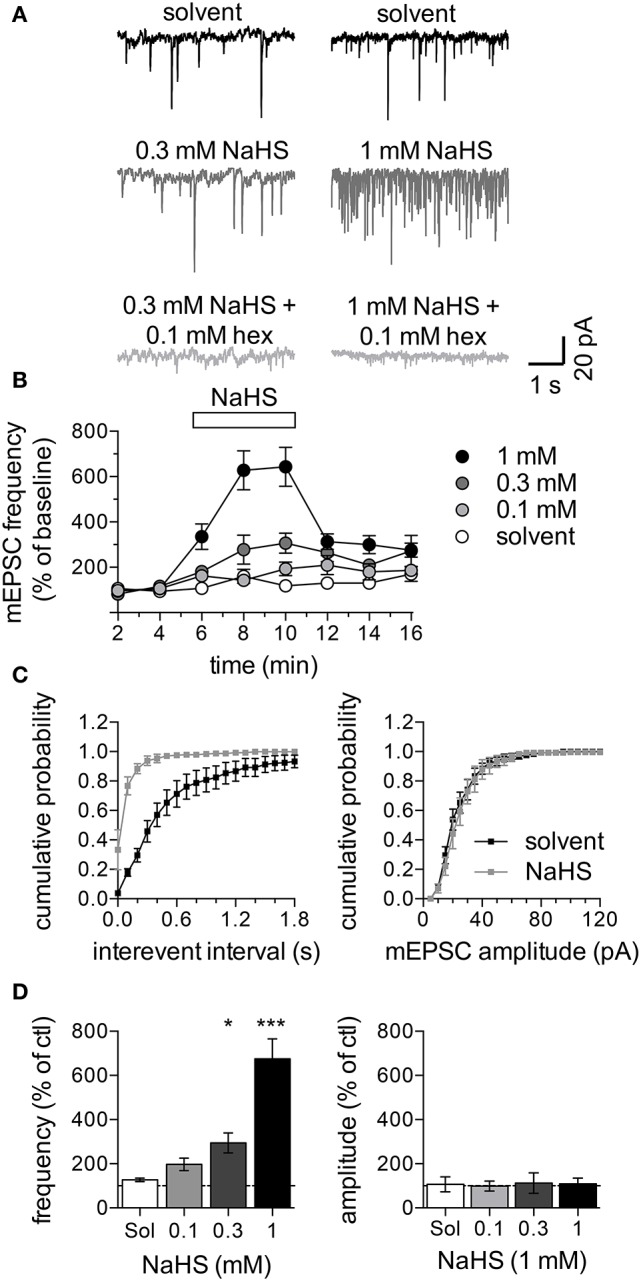
Effect of NaHS on mEPSCs in SCG neurons. mEPSCs were recorded in the perforated voltage-clamp mode in presence of 20 mM K+. (A) Representative current traces were recorded in the presence of solvent (black traces, top), 0.3 mM NaHS (dark gray, left) or 1 mM NaHS (dark gray, right) or either concentration of NaHS together with 0.1 mM hexamethonium (light gray, bottom). Panel (B) shows the time course of changes in mEPSC frequency in response to solvent (empty circles) or different concentrations of NaHS (0.1 to 1 mM, as indicated) which were present for 300 s as indicated by the rectangle. mEPSC frequencies are shown as percentage of the average control mEPSC frequencies recorded before the application of NaHS (n = 8). Panel (C) shows cumulative frequency distributions of mEPSC interevent intervals (left panel) and amplitudes (right panel) in presence of solvent (black squares) or NaHS (1 mM, gray squares) (n = 8). Panel (D) shows changes of mEPSC frequencies (left panel) and amplitudes (right panel) in response to solvent or different concentrations of NaHS (n = 8) determined at the end of the 300 s application period. * and *** Indicate significance differences vs. solvent at p < 0.05 and p > 0.001, respectively (Kruskal-Wallis test, Dunn's Multiple comparison post-hoc test).